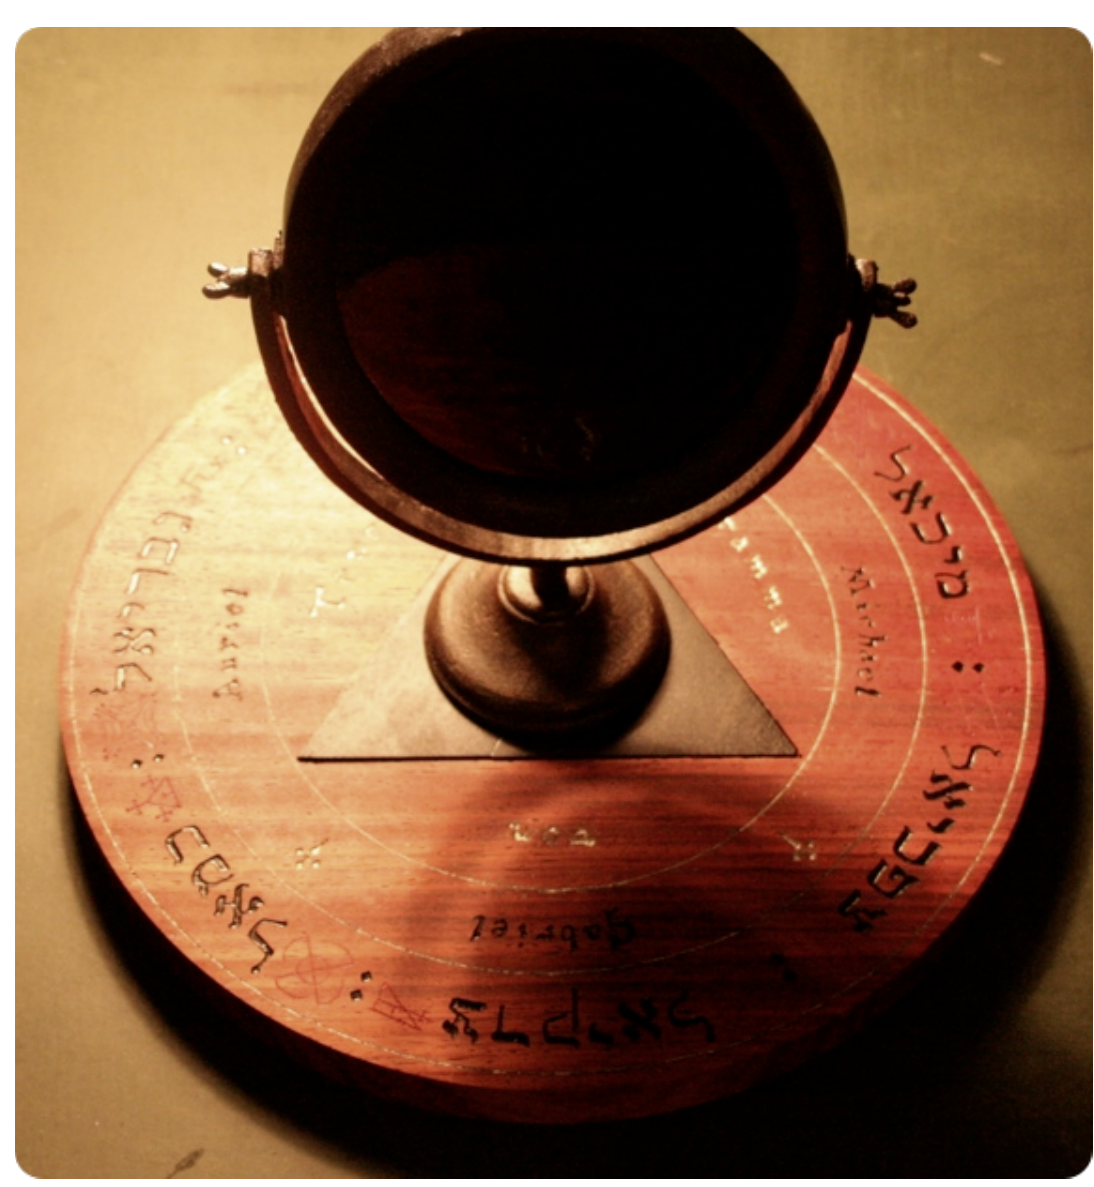
Figure 1 ‘Table of Practice,’ © Frater